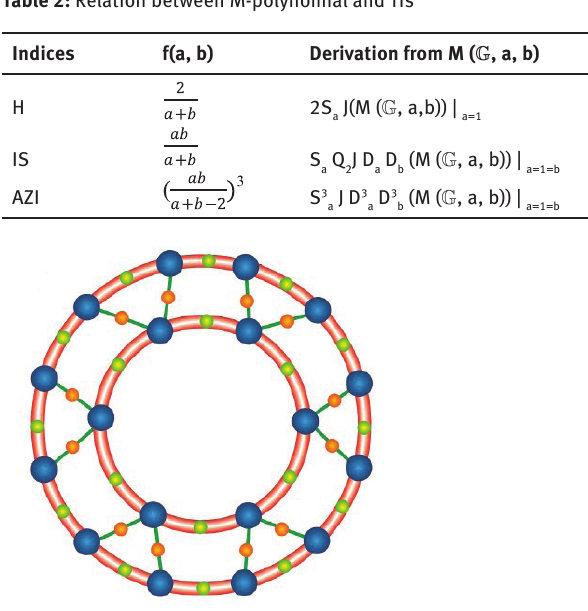
Figure 1: Basic metal-organic network.